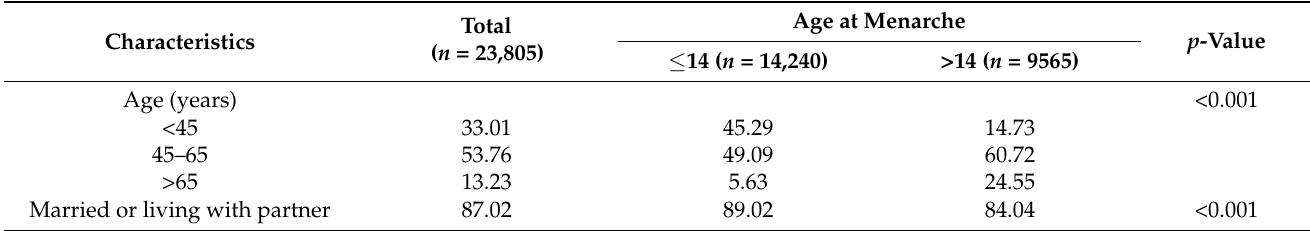
Table 1. General characteristics of the participants according to menarche